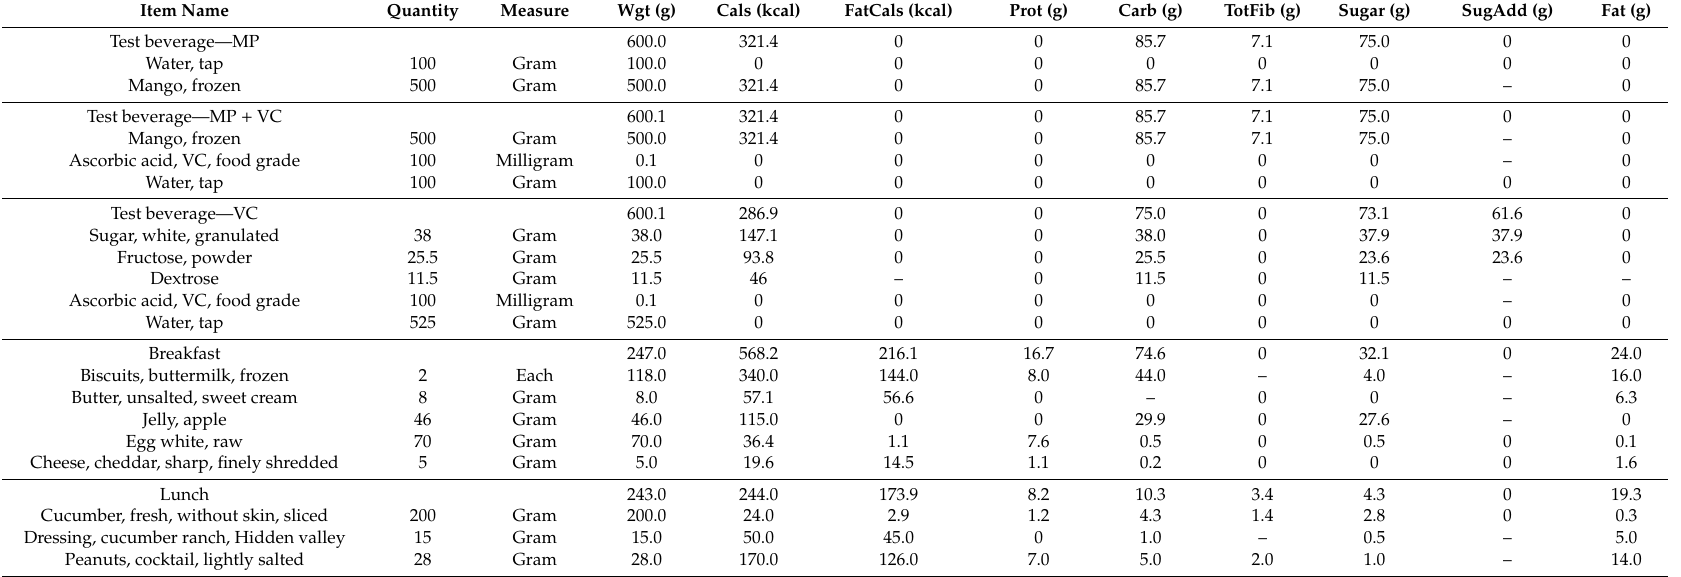
Table A3. Dietary compositions of study test beverages, breakfast and